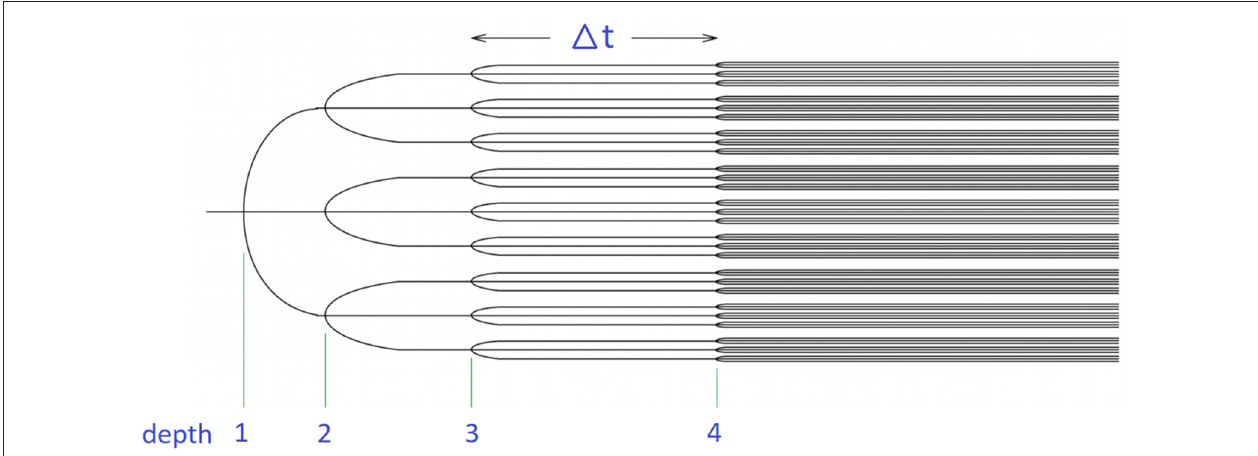
FIGURE 5 | Tree-like operator growth. The size at any circuit-depth is the final number of fermions while the complexity is the number of vertices in the diagram. In this figure the size is 81 and the complexity is 40. The complexity at the next step would be 40 + 81 = 121. The time scale for a unit change in depth is 1 t . In general 1 t may itself be time